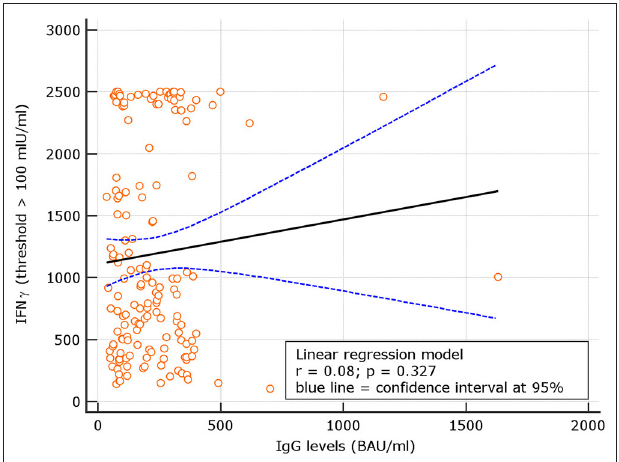
FIGURE 7 | Linear regression between IgG levels and IFN-g concentration among COVID naive group using the IFN- γ threshold of 200 mIU/ml.